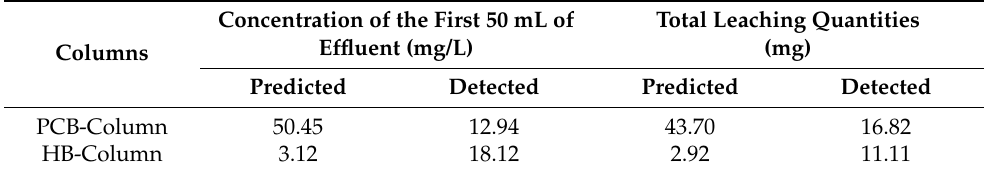
Table 4. Comparison of predicted and detected concentration and total release of ammonium in